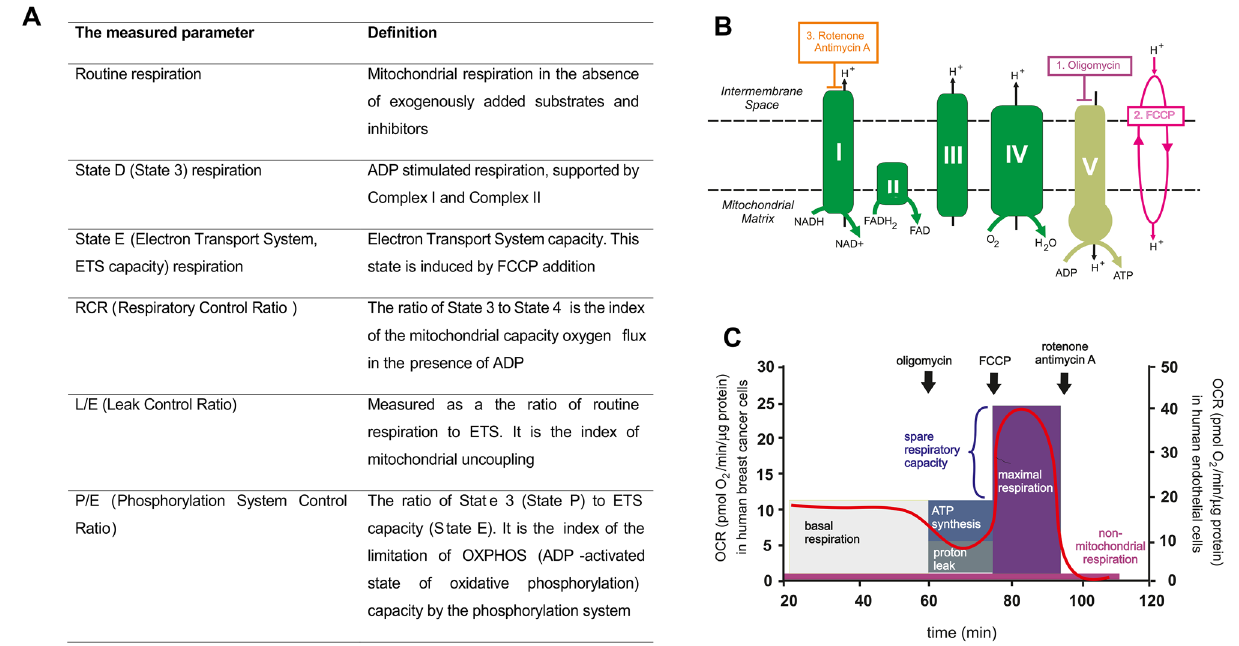
Figure 1. Principle of the mitochondrial stress assay. ( A ) Proposed definitions for cellular bioenergetics based on oxygen consumption rate (OCR). ( B ) Targets of each compound in the electron transport chain. ( C ) OCR levels refer to breast cancer and normal cells (left and right y axis, respectively) versus time (x axis). Injection of the three compounds oligomycin, FCCP, and antimycin A/rotenone delimited four time intervals within